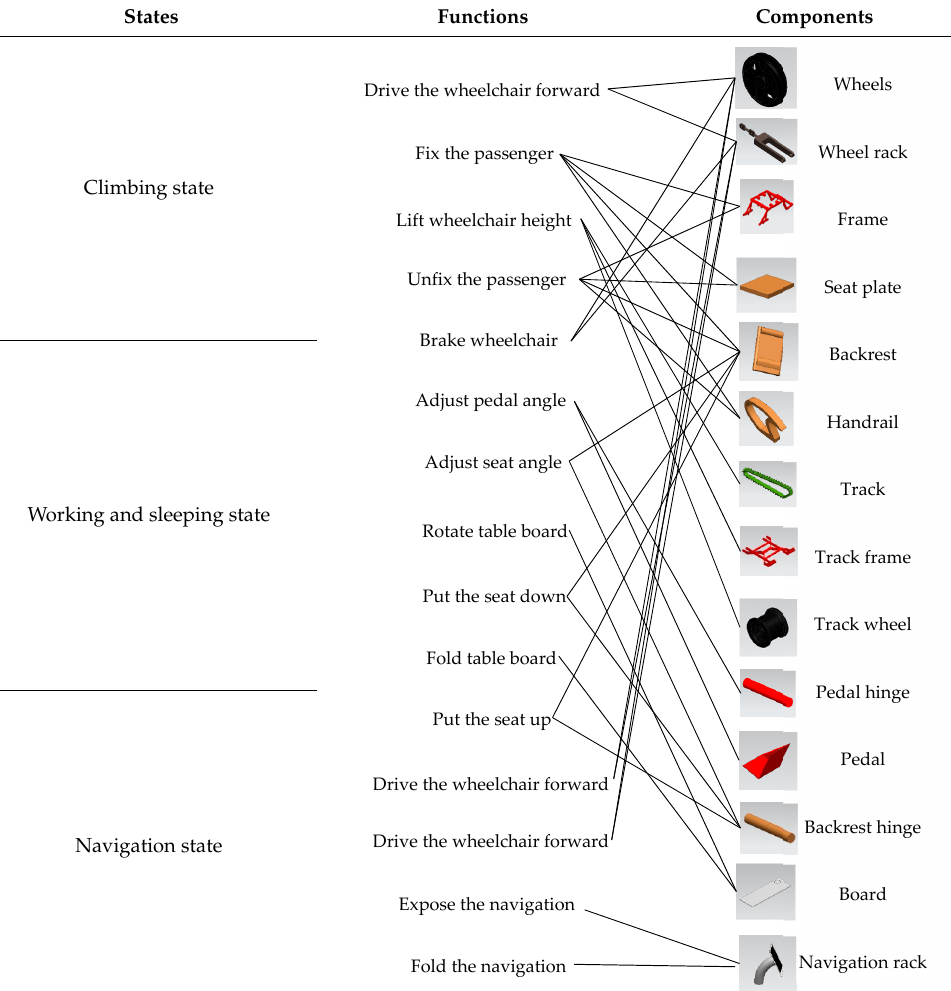
Figure 13. The first conceptual design of the wheelchair. ( a ) in climbing state, ( b ) in working state, ( c ) in sleeping state, ( d ) in navigation state.